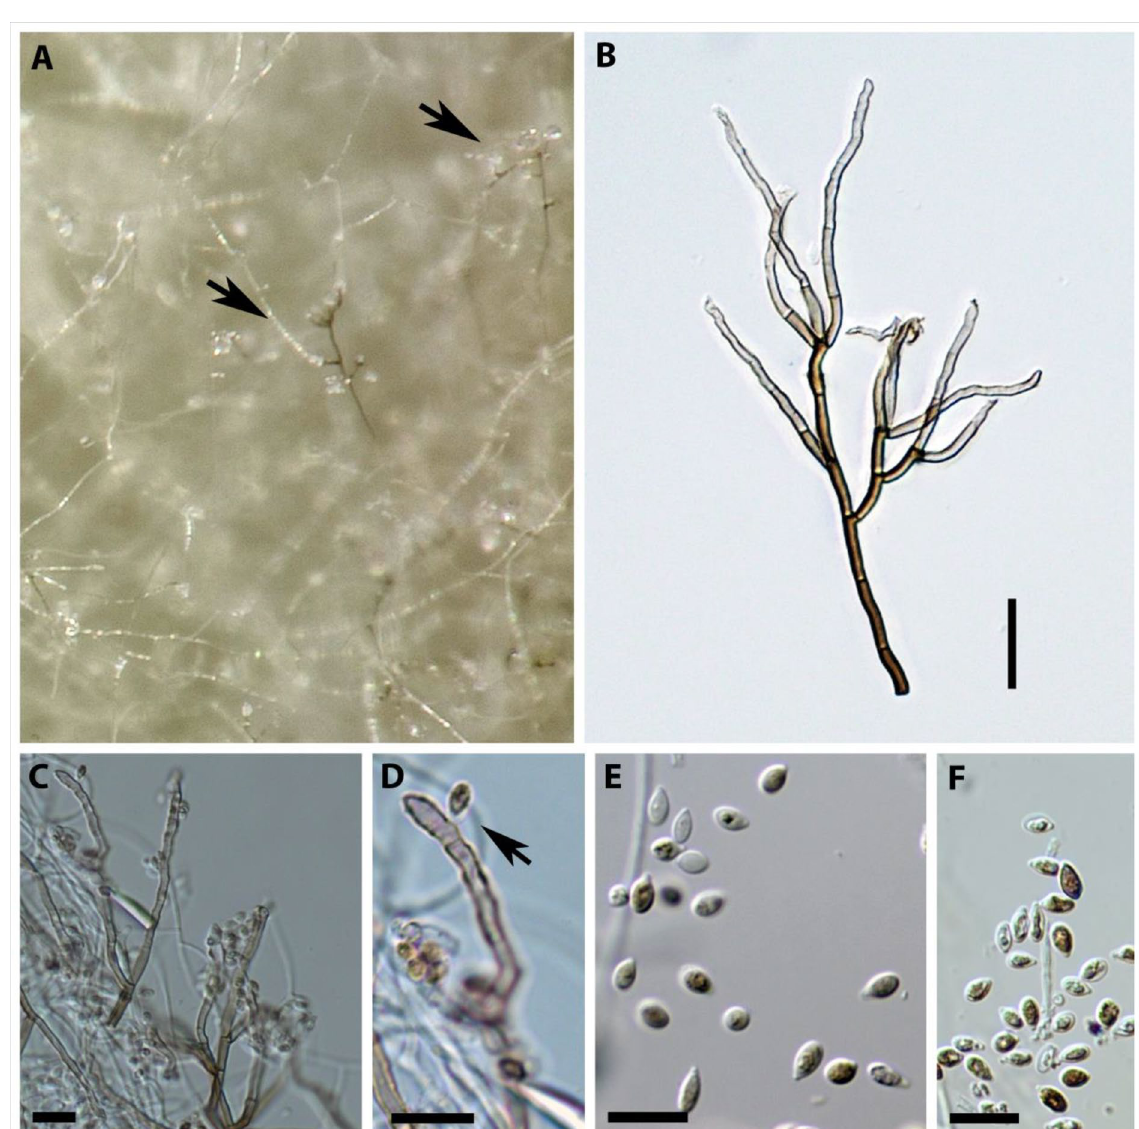
Fig. 2 Morphology of the anamorph of the ex‑type strain of Induratia apiospora (ATCC 60639) on YM6.3. A Conidiophore on surface mycelium. B Single nodulisporium‑like conidiophore. C , D Conidiogenous cells. E , F Conidia. Scale bars: B 20 µm, E , F 10